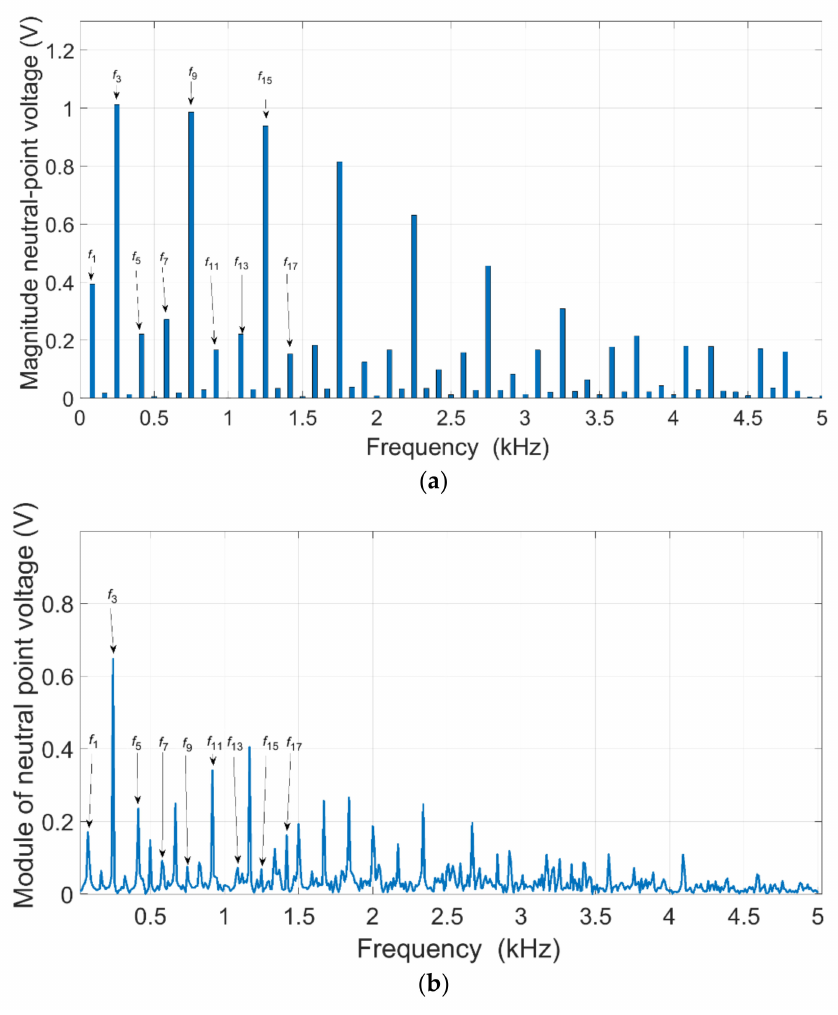
Figure 18. Y (cid:52) configurations—FFT of neutral voltage—SC2: ( a ) numerical calculations, ( b )